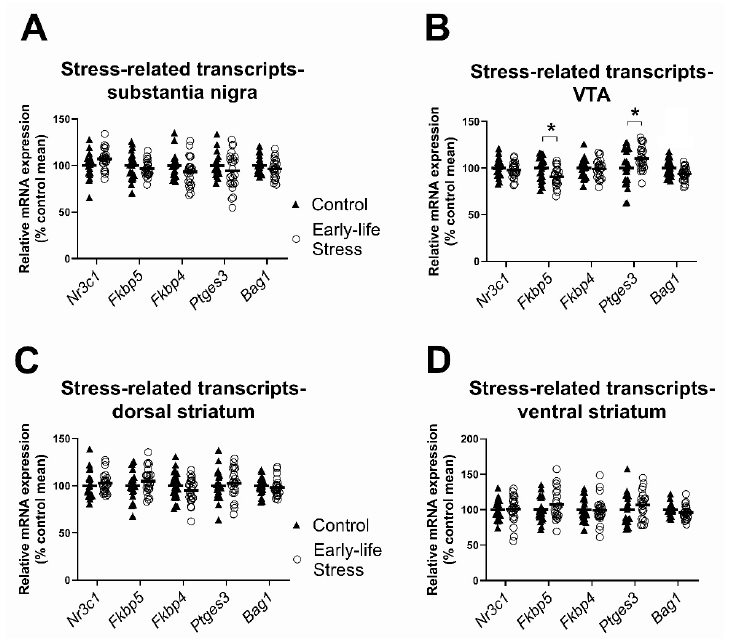
Figure 2. Effects of early life stress on stress-related transcript levels. ( A , C , D ) There were no main effects of early life stress in the substantia nigra, dorsal striatum or ventral striatum; ( B ) maternally separated rats of both sexes had lower Fkbp5 and higher Ptges3 mRNA in the VTA than control rats. Data are expressed as a percentage of the control group mean. Each data point represents a single animal. Filled triangles and hollow circles represent control and early life stress animals, respectively. Horizontal lines depict group means. * p < 0.05. Table 1. Two-way ANOVA showing main effects of early life stress and sex, as well as interactions between early life stress and sex, on stress signalling-related transcripts in the substantia nigra, VTA, dorsal striatum and ventral striatum of 22 control and 24 maternally separated rodents. Asterisks (*) indicate genes whose log-transformed data were used for statistical analysis. VTA = ventral tegmental area; GR = glucocorticoid receptor. Bold type indicates statistically significant effects.